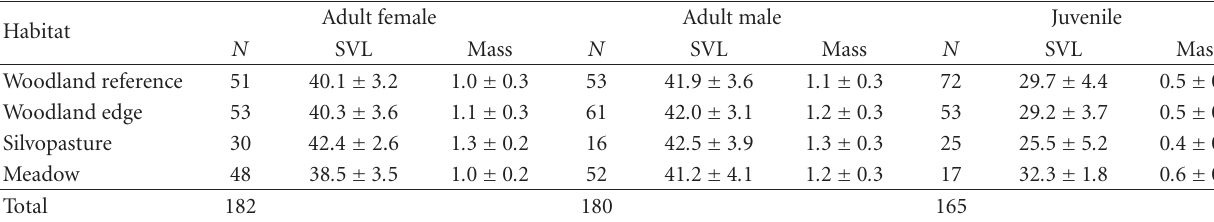
Table 1: The number of captures ( N ), mean snout-vent length (SVL; mm), and mean mass (g) of adult female, adult male, and juvenile Plethodon cinereus within woodland, woodland edge, silvopasture, and meadow habitats in southern West Virginia, 2004-2005. Means are reported ± 1 SD.